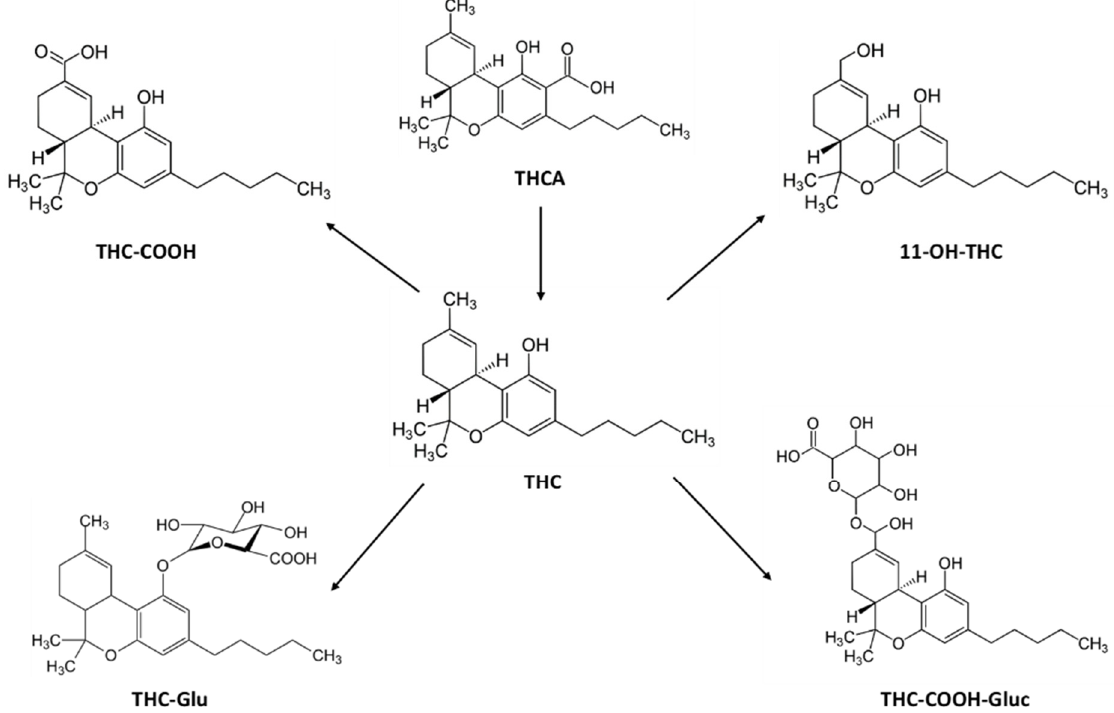
∆ 9-tetrahydrocannabinol (THC), its acidic precursor, and its Figure 1. Chemical structures of Δ 9-tetrahydrocannabinol (THC), its acidic precursor, and its metabolites. Figure 1. Chemical structures of